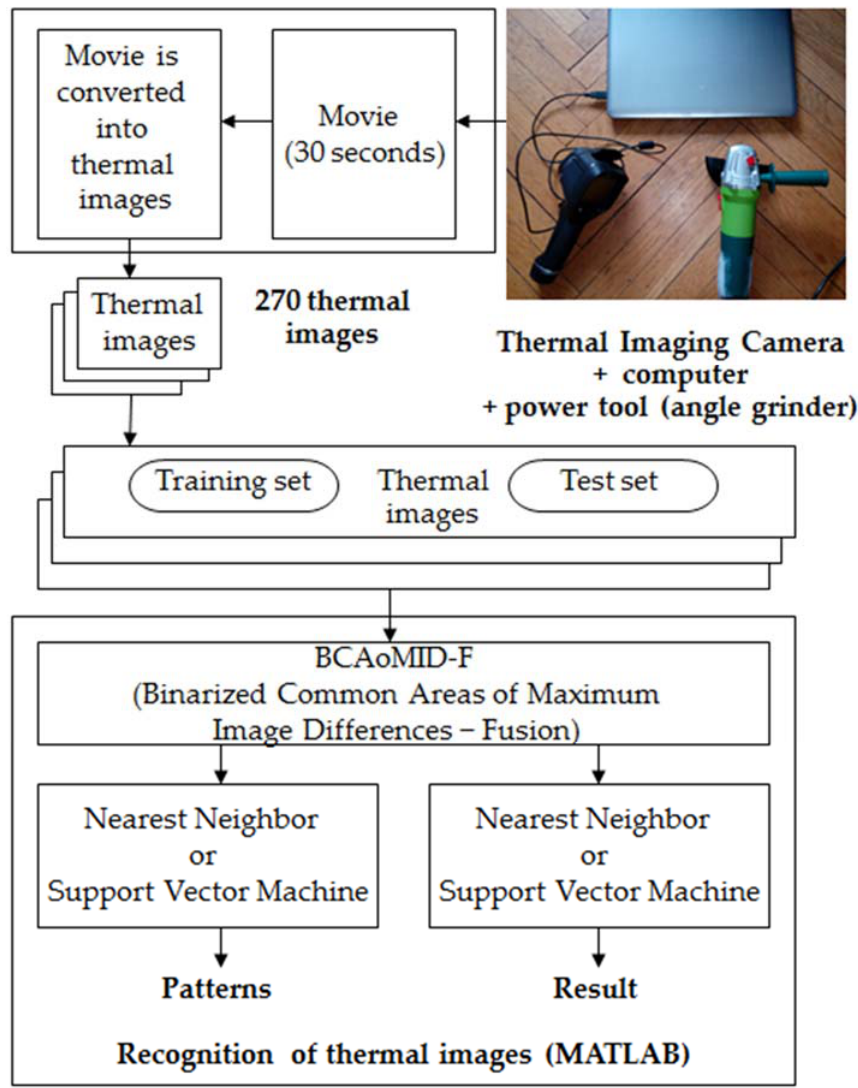
Figure 2. Processing and recognition of thermal images of the angle grinder.